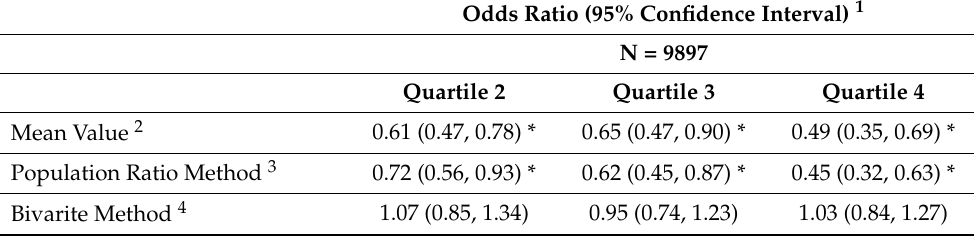
Table 5. Association between Alternate Mediterranean Diet score (aMED) and moderate to severe depressive symptoms, NHANES 2007–2012 using two 24-h diet